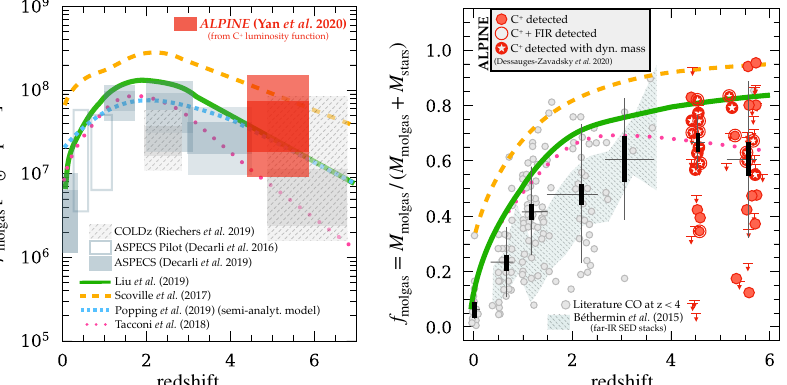
Figure 6. Left Panel: Molecular gas density as a function of redshift (following closely the cosmic SFR density, see Figure 5). The measurement from ALPINE from Yan et al. [64] is indicated by the red box. Other measurements from COLDz (hatched boxes; [82]) and ASPECS (filled and empty gray boxes; [69,81]), together with empirical models from [125] (green solid), Scoville et al. [11] (orange long-dashed), and Tacconi et al. [130] (pink dotted) are also shown. The semi-analytical model from Popping et al. [78] is shown as a short-dashed blue line. Right Panel: Redshift evolution of molecular gas mass fraction of galaxies from z =0–6. The curves show the same empirical and semianalytical models as indicated on the left panel. Measurements at z = 4.6 from ALPINE [129] are shown in red (distinguishing from C + detected, far-IR detected, and measurements with dynamical mass). Literature CO data at z < 4 are shown as gray points (see Dessauges-Zavadsky et al. [129] for references), together with the far-IR SED stacks from (hatched region Béthermin et al. [119]). Large black crosses show the median (with error on the mean and scatter) in 7 redshift